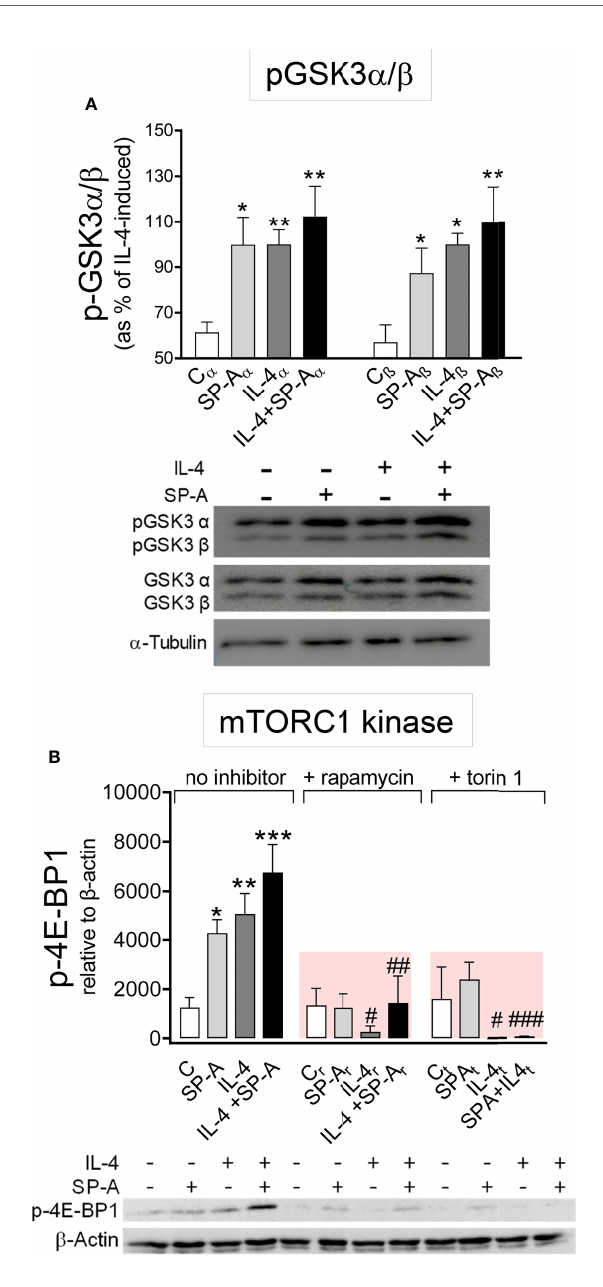
FIGURE 4 | SP-A and IL-4 enhance GSK3 a / b phosphorylation and mTORC1 activation. (A) AMs were stimulated with or without IL-4 (1 m g/ml) and/or SP-A (100 m g/ml) and phosphorylation of GSK3- a / b (Ser21/9) was measured. (B) Puri fi ed rat AMs were pretreated with 20 nM rapamycin, 100 nM torin 1, or vehicle (no inhibitor) for one hour. Cells were then stimulated with or without IL-4 (0.5 m g/ml) in the presence or absence of SP-A (40 m g/ ml). p-4E-BP1(Ser65) relative to b -actin was quanti fi ed by Western blot. Representative Western blot analyses are shown below each graph. The results are presented as means (± SEM) from three different AM cultures with at least three biological replicates. ANOVA followed by the Bonferroni multiple-comparison test was used. * p < 0.05, ** p < 0.01, and *** p < 0.001 when compared with untreated macrophages. # p < 0.05, ## p < 0.01, and ### p < 0.001 when the effect of either rapamycin or torin1 is compared with the same sample without